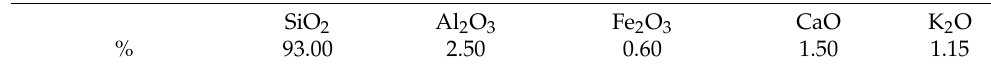
Table 1. Particle size analysis and chemical and hydraulic parameters of the homogeneous sand used